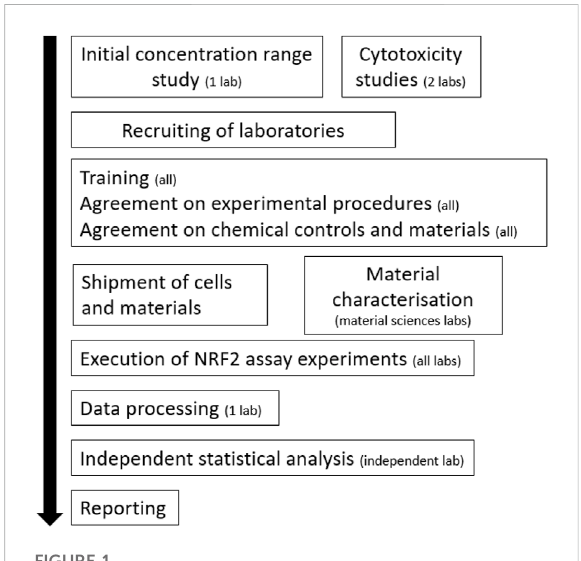
FIGURE 1 Work fl ow of the pre-validation experiments. The number of laboratories involved is